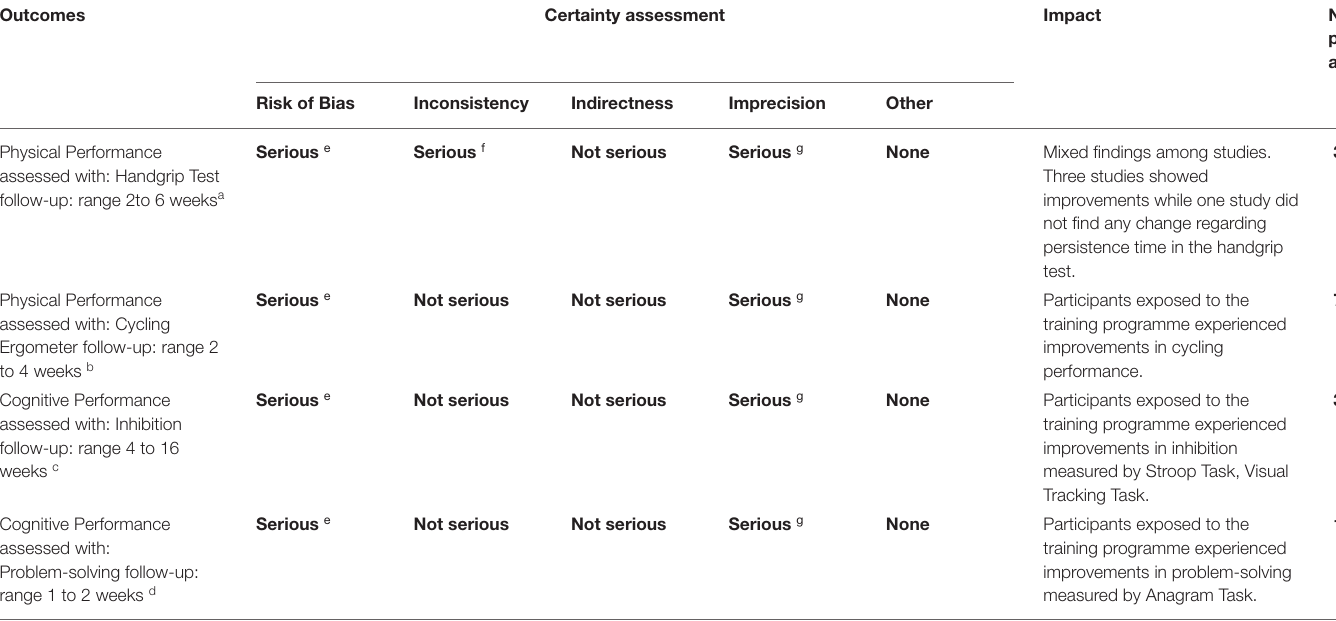
TABLE 3 | Summary of findings table for self-regulatory strength training programmes. Outcomes Certainty